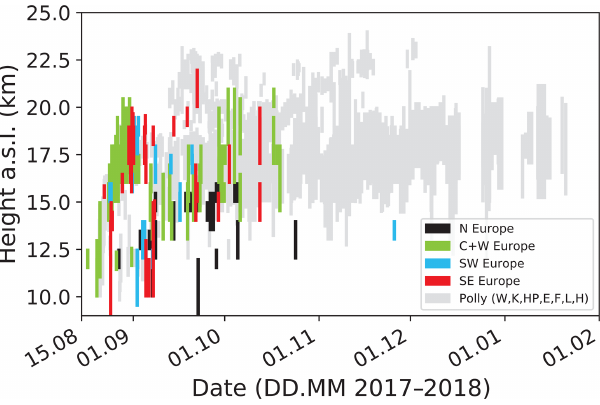
Figure 3. Overview of the lidar network observations of strato- spheric smoke from August 2017 to January 2018. Each observation is represented as one colored vertical line indicating the vertical ex- tent from layer base to top (in height above sea level, a.s.l.). One observation per day and site is considered. The colors separate the different European regions of the EARLINET stations as defined in Fig. 1. Polly observations (collected at Évora, Hohenpeissenberg, Košetice, Warsaw, Finokalia, Limassol, and Haifa) are given here as grey background and are presented in Fig.